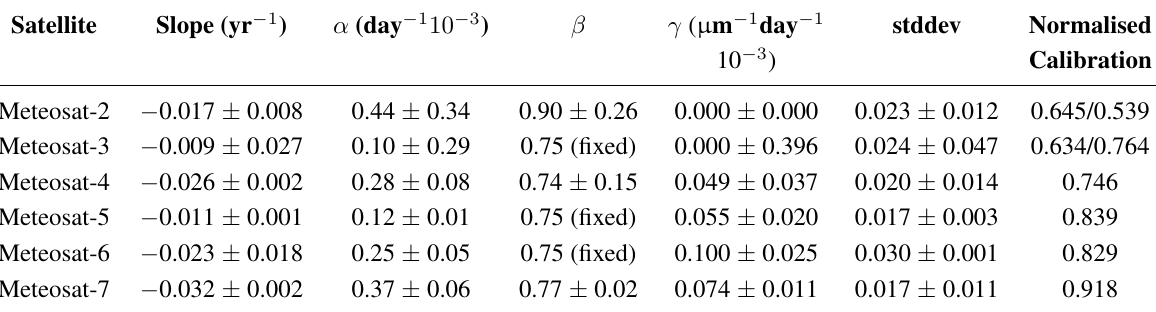
Table 7. For each satellite, the optimal values for the 4 model parameters, the square root of the minimized costfunction (stddev), and the normalized calibration coefficients are